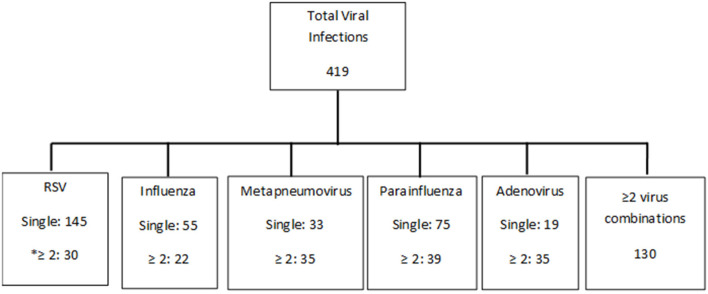
Breakdown of viruses. *≥2 includes of combinations of viruses (most common combination was with enterovirus, rhinovirus, and coronavirus addition to be a combination of the above five viruses).